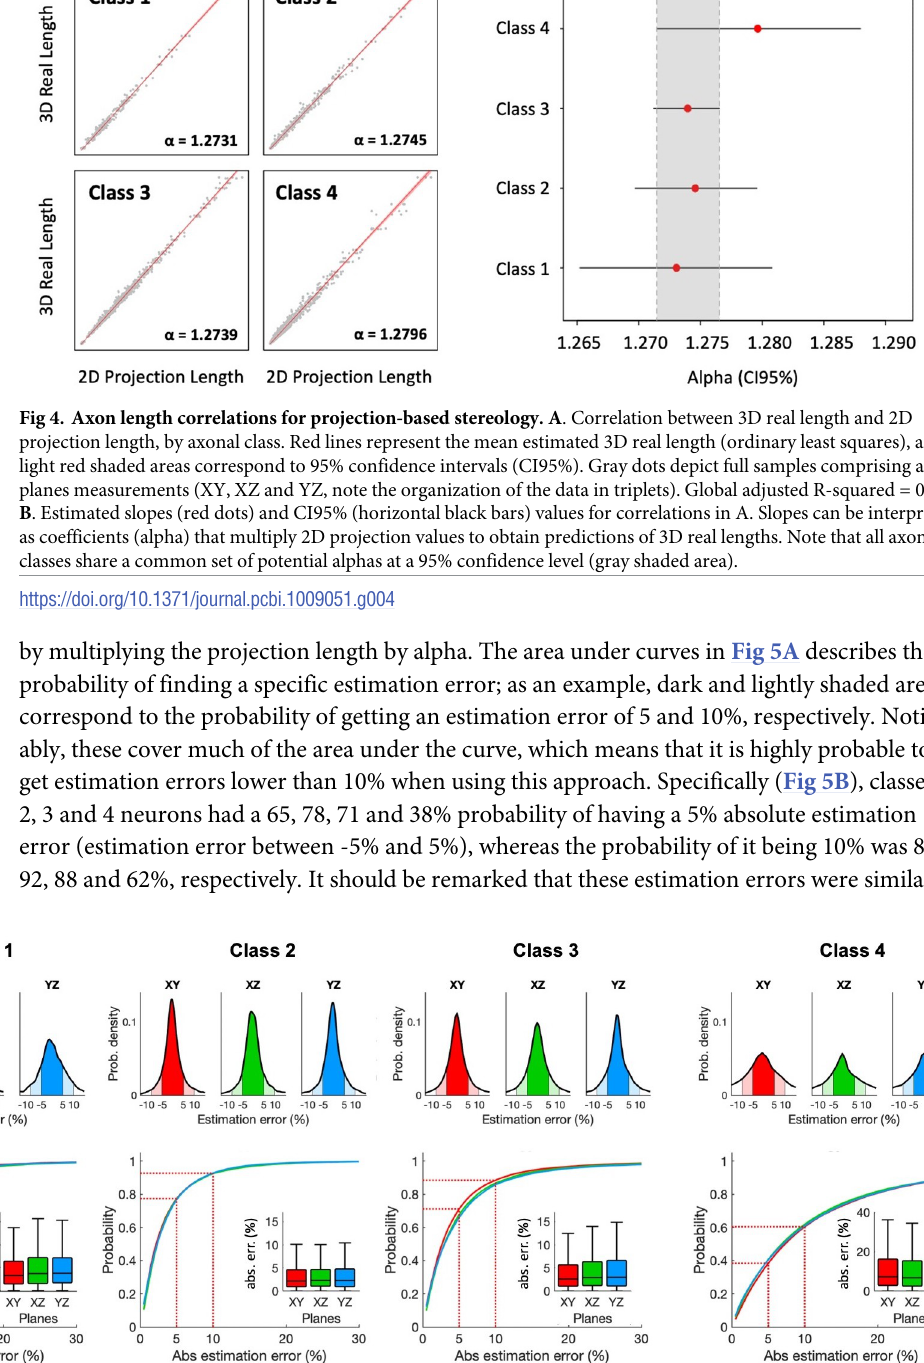
Fig 5. Estimation error probability projection-based stereology. A . Estimation error is distributed according to the shown probability densities (axon classes in columns; red, green, and blue for XY, XZ, and YZ planes respectively). The probability of getting a certain error during axon length estimation will be given by the area below the curves (dark and light colors for + 5% and + 10% estimation error respectively). B . Absolute estimation error vs. probability (given by the area below the curves in A). Dashed lines point the probabilities of estimating axon length with absolute errors of 5% and 10%, (colored areas in A). Insets. Absolute error distributions for planes XY, XZ, and YZ.